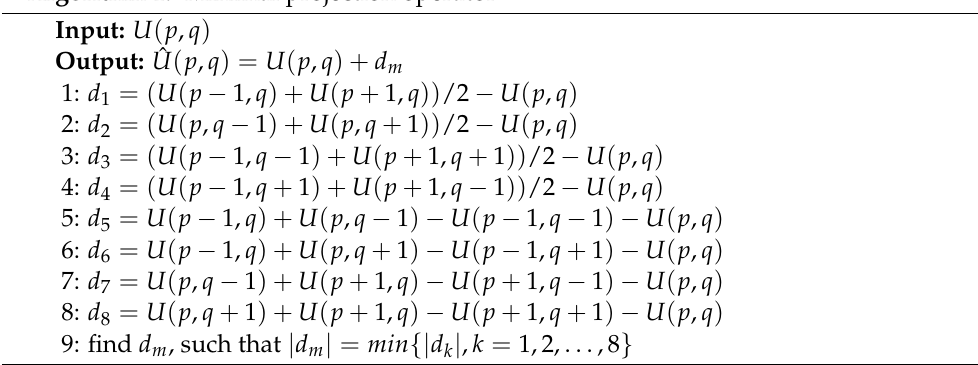
Algorithm 1: Minimal projection